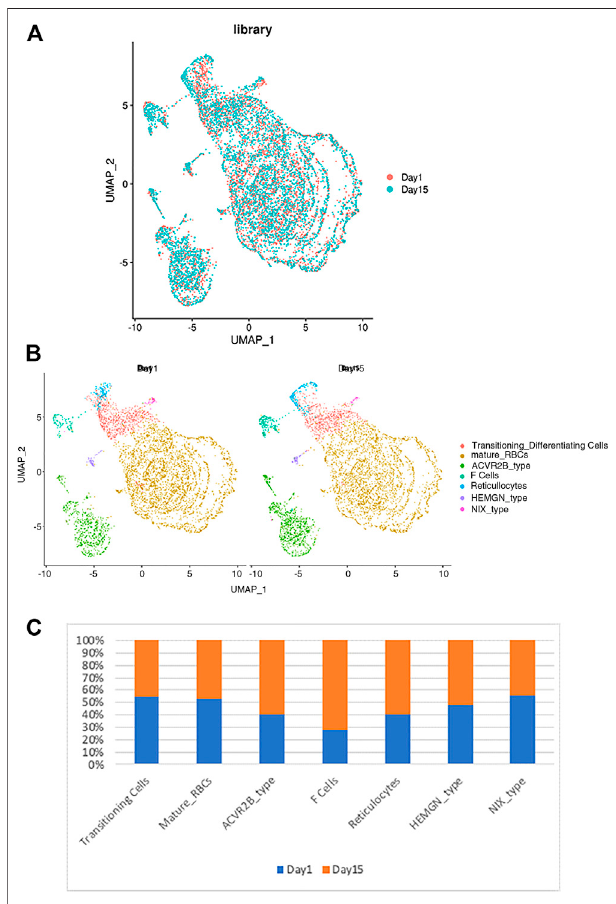
FIGURE 3 | The relationship between the RBC clusters and storage times. (A) The indicated storage days of individual RBCs were projected into the UMAP clusters of RBCs. (B) The UMAP presentation of the heterogeneous clusters of separate RBCs which have been stored for one (left) or 15 days (right). (C) The relative frequency of the seven representative RBC clusters in day 1 vs. 15 showing an increase in ACVR2B and F-cells in ex vivo stored